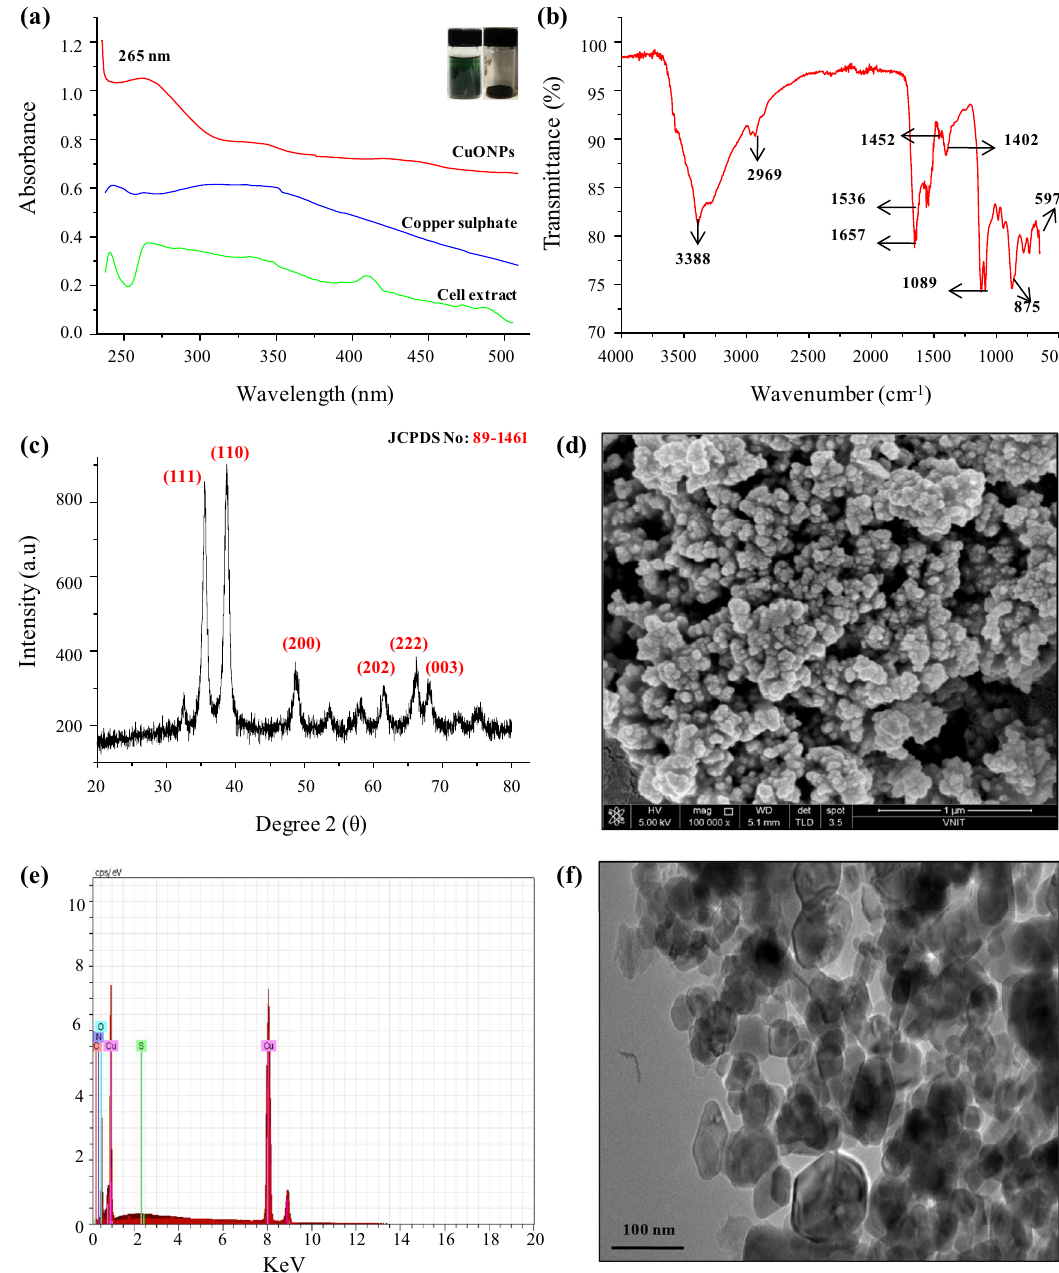
Figure 1. Characterization of Phormidium sp . derived CuONPs; ( a ) UV–visible spectrum; ( b ) FTIR spectrum; ( c ) X-ray diffractogram; ( d ) SEM analysis at a direct magnification of × 10 000; ( e ) EDX graph and ( f ) TEM micrograph. The inset in panel ( a ) depicts the green color of cell extract and powder form of